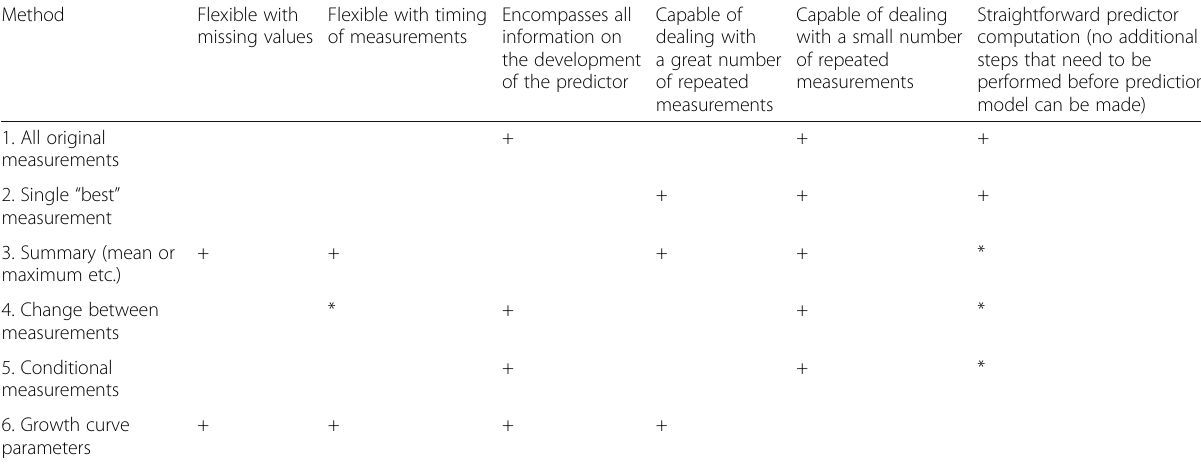
Table 3 Characteristics of the methods for developing a prediction model with a longitudinal predictor